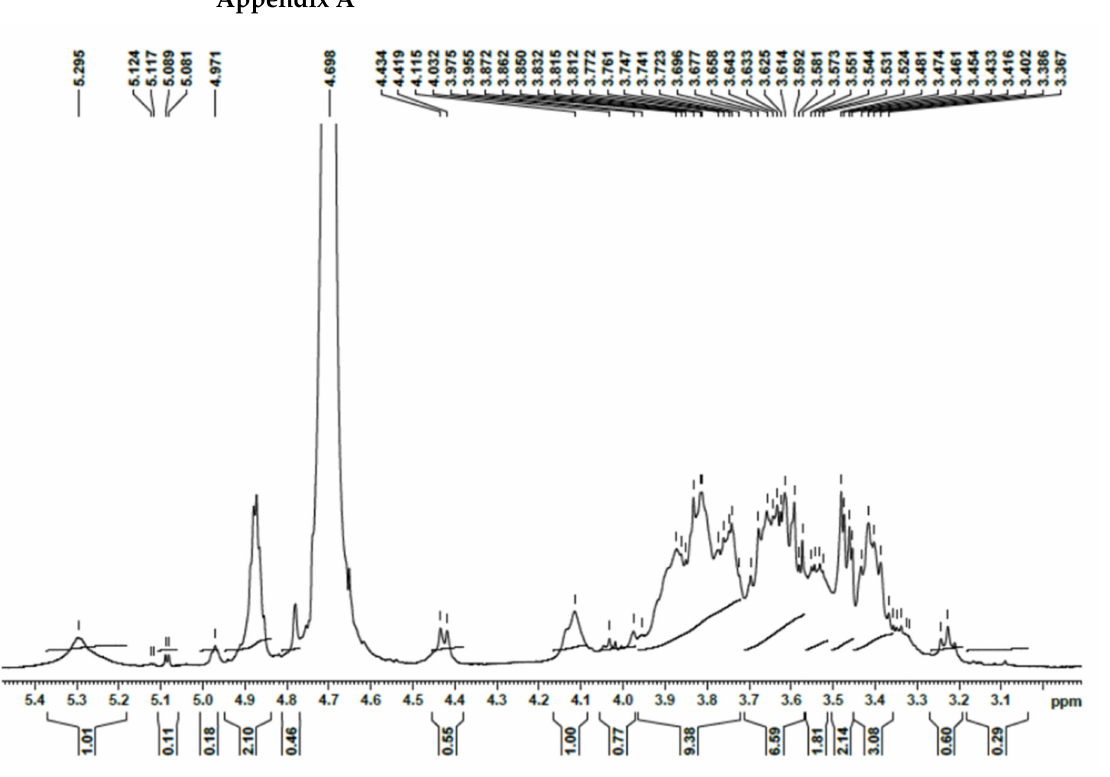
Figure A1. 1 H spectra of